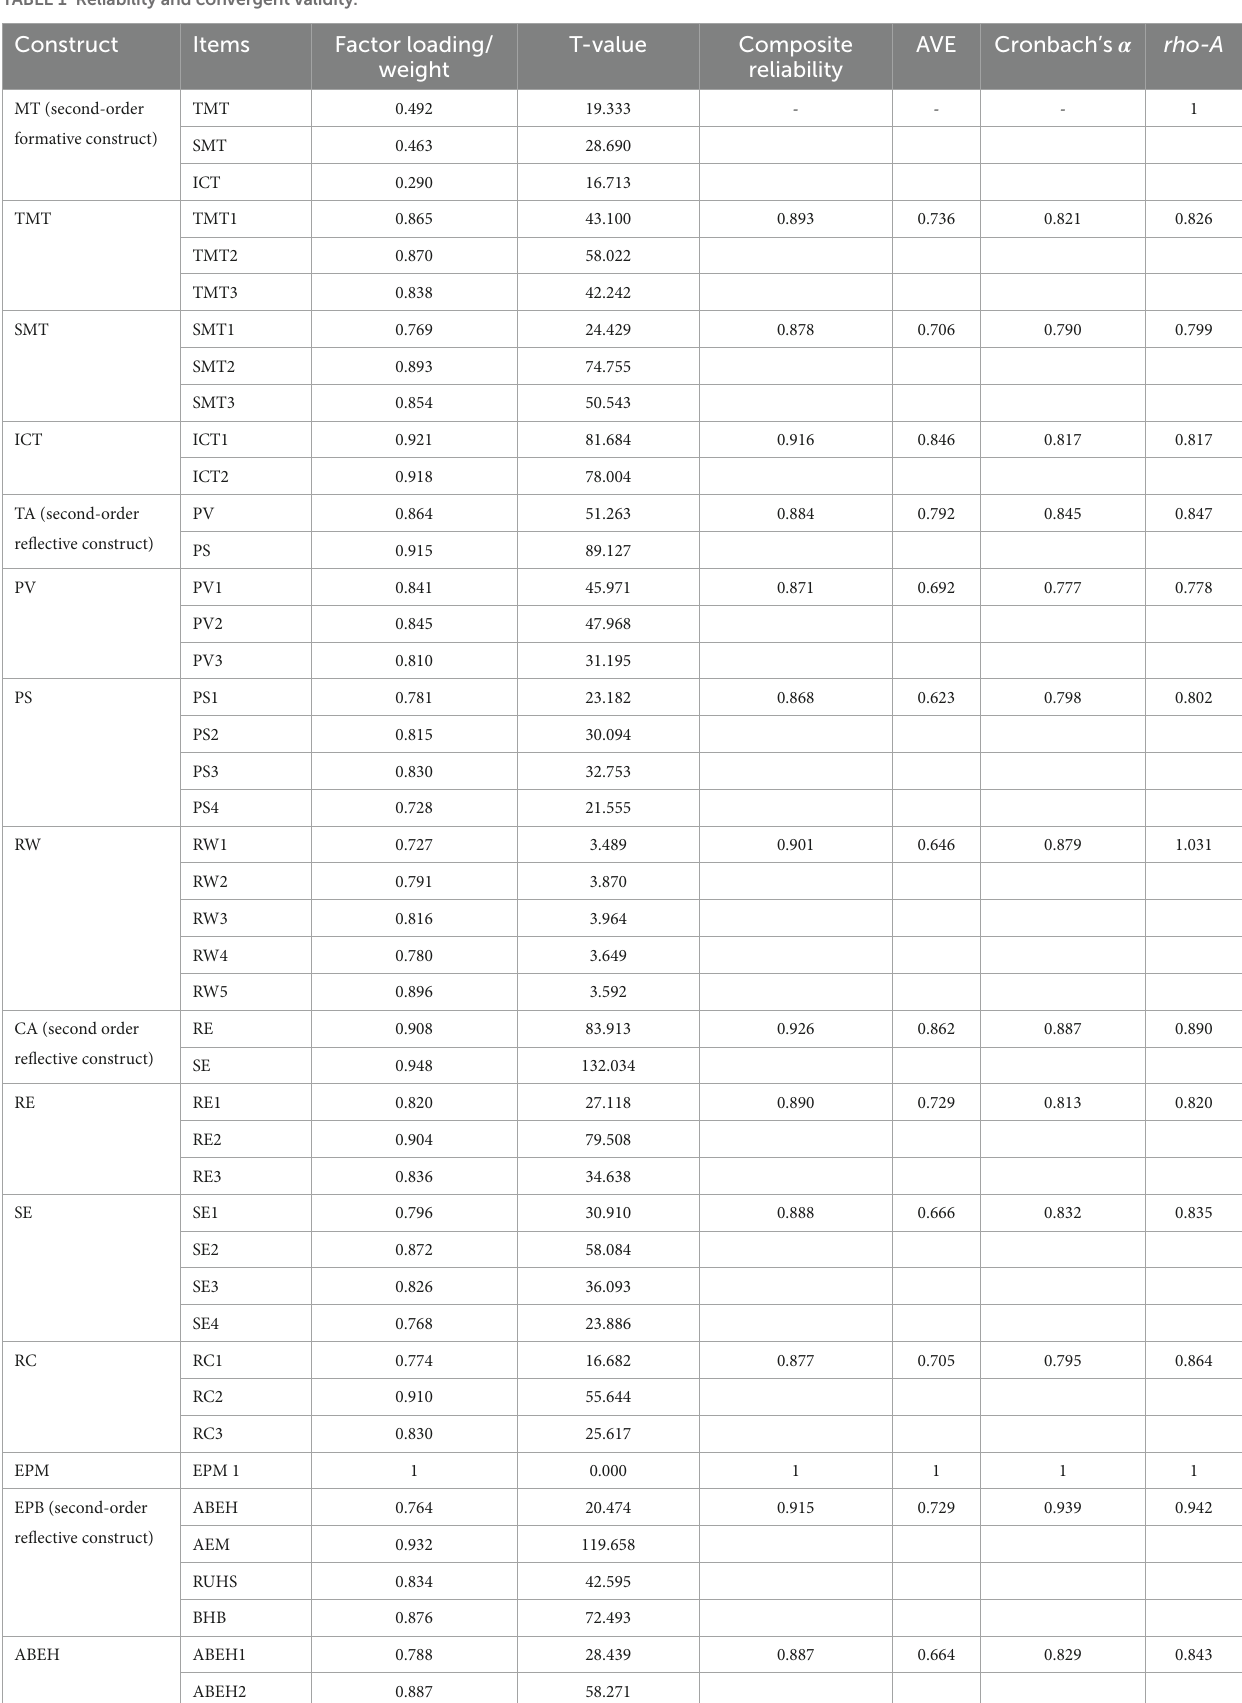
TABLE 1 Reliability and convergent